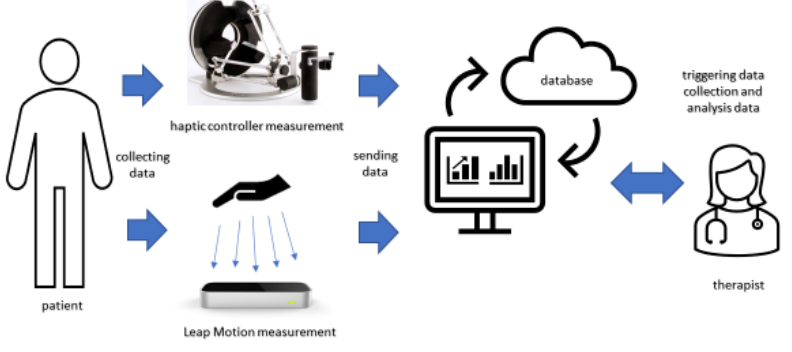
Figure 1. Elements of measurement system based on haptic and vision devices.